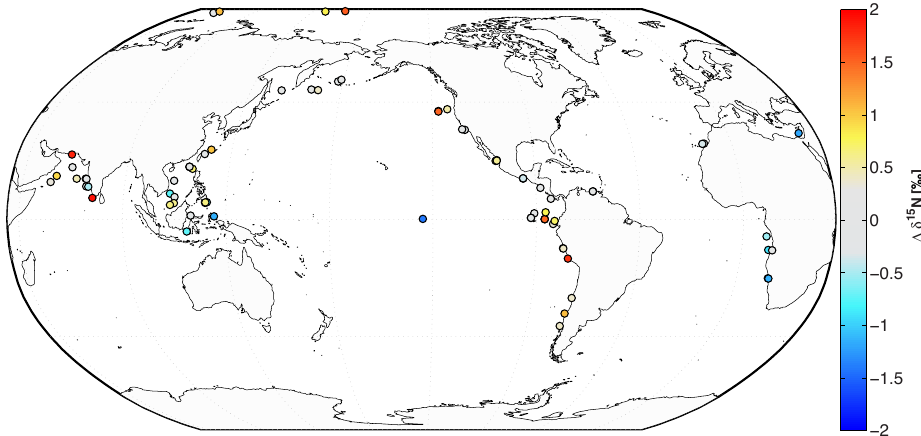
Fig. 7. Difference between surface and LH δ 15 N averages for available sites. The difference is calculated as δ 15 N seafloor − δ 15 N LH , such that positive values indicate that the average δ 15 N of the seafloor sediments is higher than that of the late Holocene.